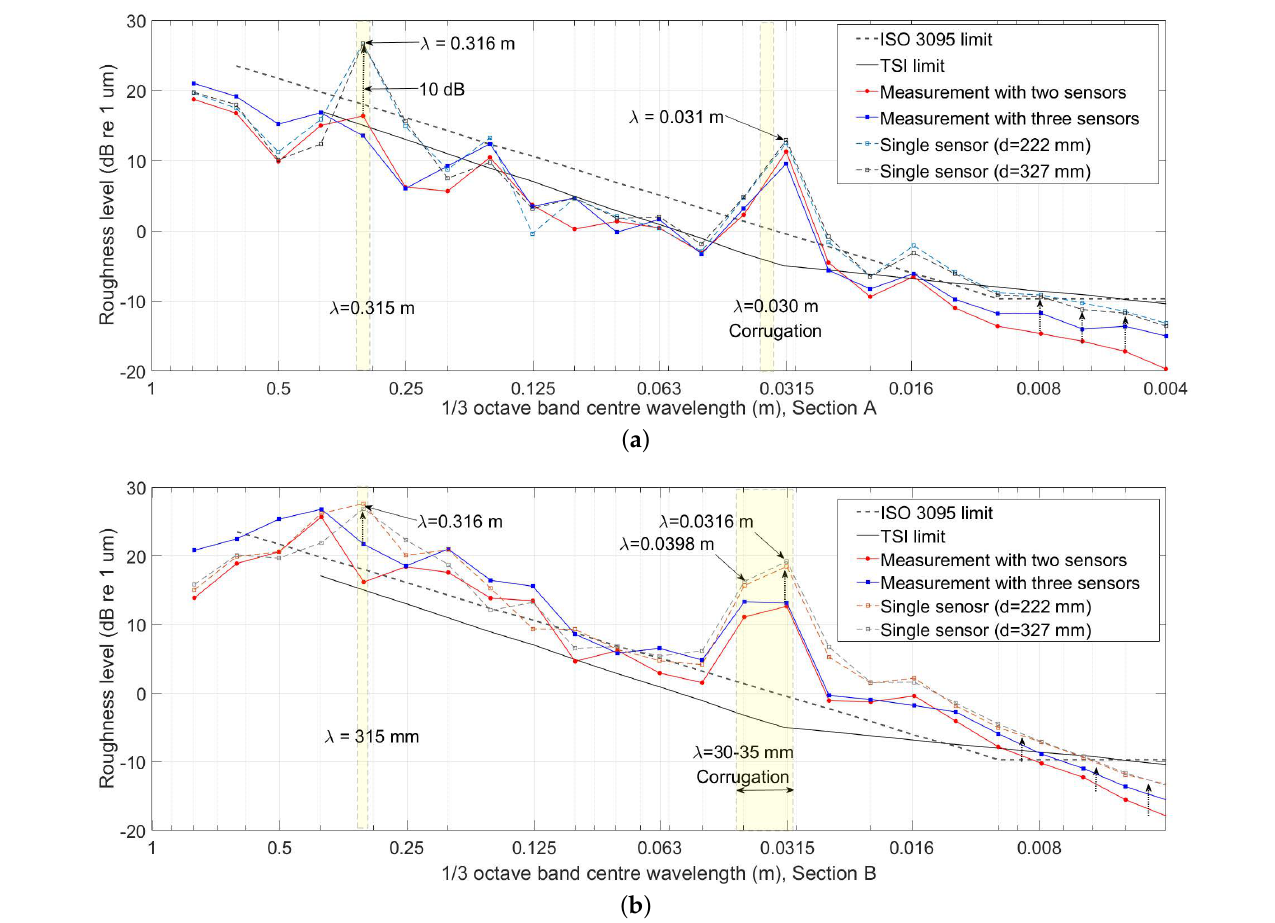
Figure 8. Spectral analysis of longitudinal rail roughness in operational field track: ( a ) Section A, ( b ) Section B. The spectrum of rail surface roughness was measured three months after initial measurement to observe any changes in rail surface corrugation due to train operations, as shown in Figure 9. When using two and three sensors, the sensor positions shown in Table 1 were used as in the previous measurement, while single-sensor measurements were not used as there were many cases of distortion, as shown in Figure